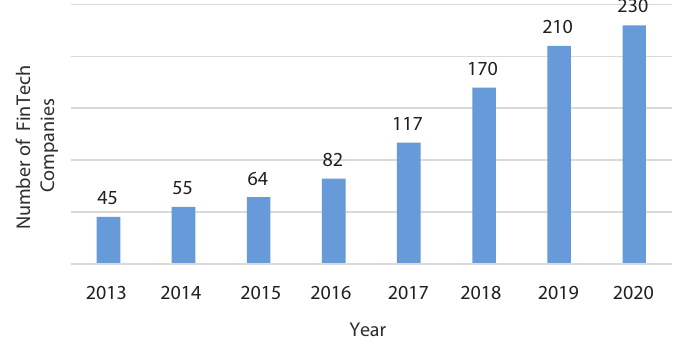
Figure 1. Number of FinTech companies in Lithuania at the end of the year (source: created by authors, according to data based on Invest Lithuania,